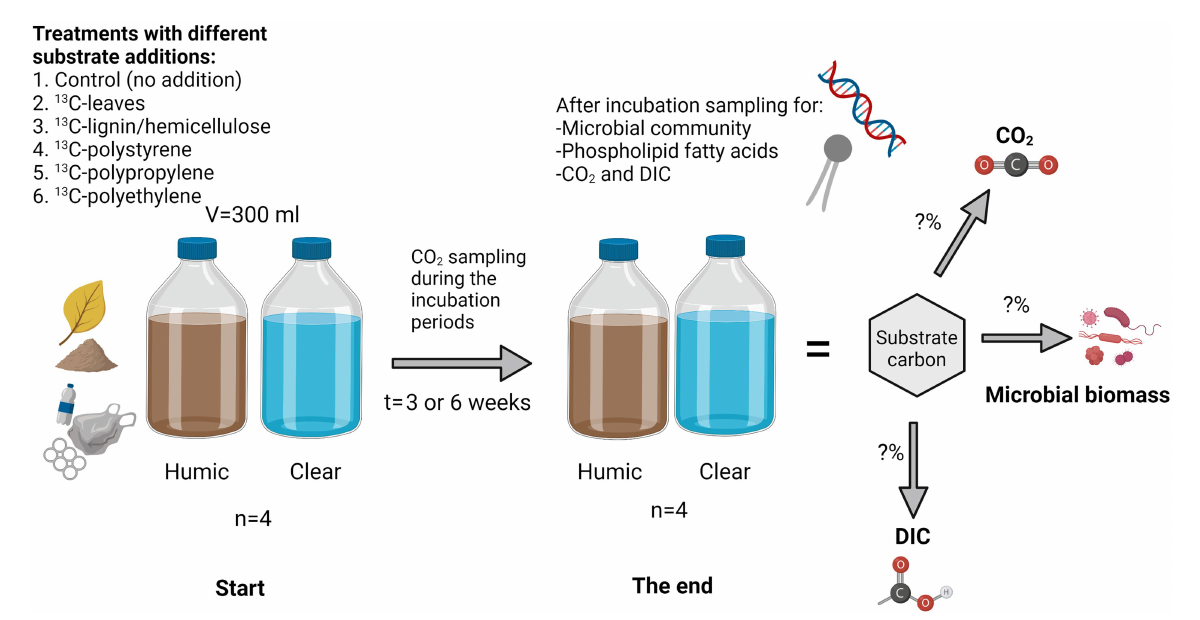
FIGURE 1 Experimental setup. Various carbon sources (1-6) were incubated in clear and humic lake water after which the transfer of carbon into microbial biomass and inorganic carbon was studied using stable isotope analyses. Microbial community analyses and compound-specific isotope analysis were used to identify microbial taxa involved in the decomposition